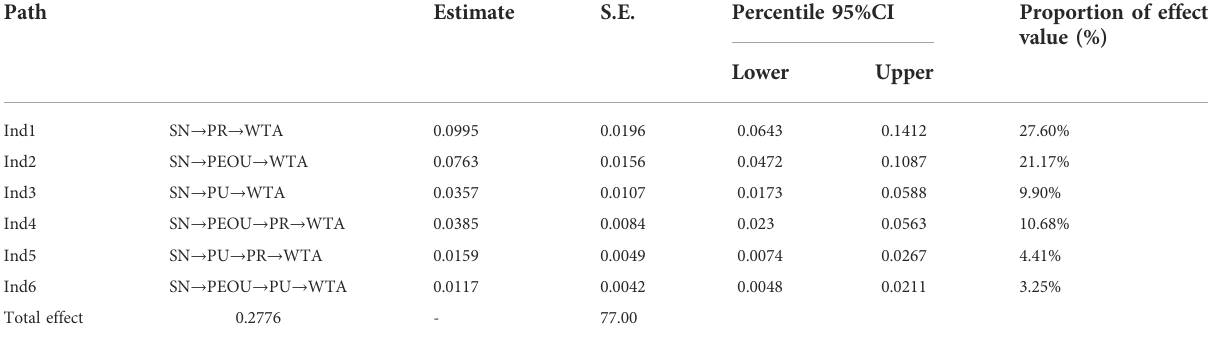
TABLE 7 Results of multiple mediating